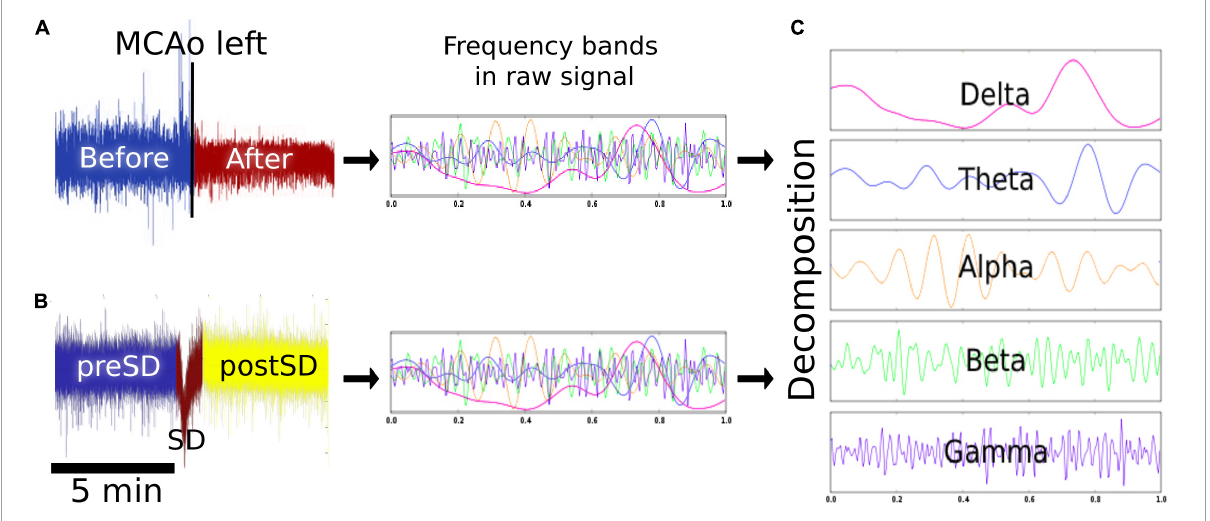
FIGURE2 Signal analysis. (A) Effects of MCAo on the brain electrical activity. Five-minute epochs were obtained before, 5 min, and 4, 8, and 12 h after the left MCAo to analyze the modifications in the spectral power of each frequency band over time. (B) Effects of SD on the brain electrical activity. The SD signal was studied 5 min before (preSD), during (SD), and 5 min after the near DC-shift (postSD) to observe the alterations caused by the development and passage of the SDs. (C) Signal decomposition: the signal segments were decomposed to delta, theta, alpha, beta, and gamma bands. MCAo, middle cerebral artery occlusion; SD, spreading depolarization; DC, direct